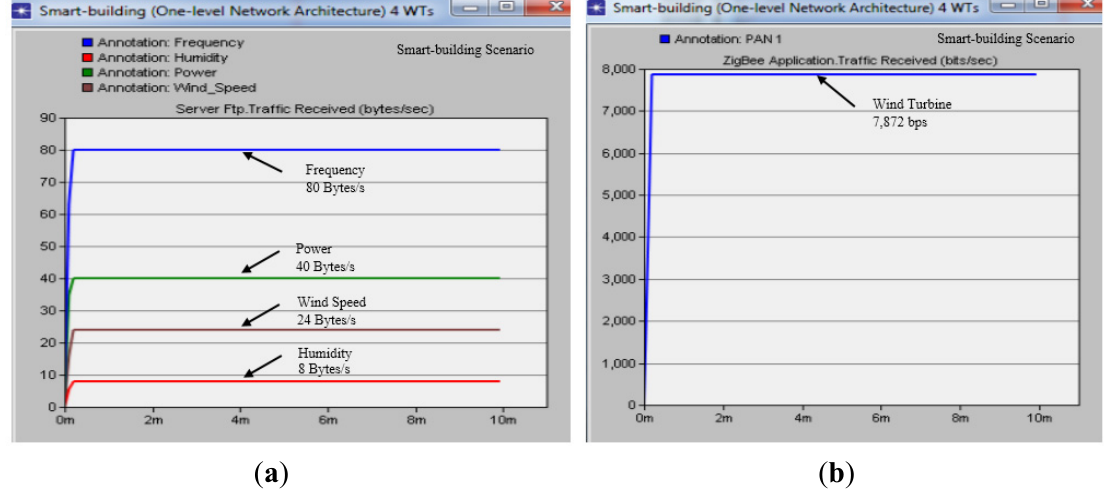
Figure 12. Received traffic at the server for small WTs in the smart-building scenario. ( a ) Ethernet-based architecture; ( b ) ZigBee-based